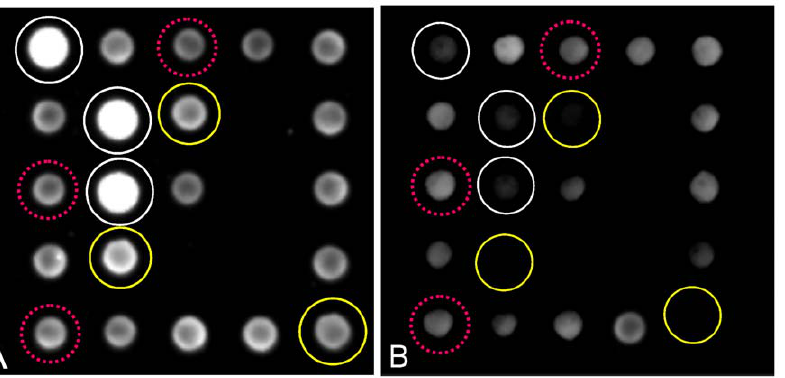
Figure 2. Differences in fluorescence signal intensity on the capture probe array at the first and the last cycle of a monoplex amplification reaction. A. An image of a hybridization pattern at the first cycle of the amplification reaction is shown. No target amplicon is present in the solution. The capture probe for the HIV-1 target specific reporter probe hr_H1_683 (solid yellow circle) as well as the non-target specific reporter probes, for example hr_H1_IPC (dotted red circle) show maximal signal intensity under the given reaction conditions. Initially, all reporter probes are free to bind to their respective capture probes on the array and show maximal signal intensity. The capture probe for hr_NHC shows no hybridization signal due to absence of a corresponding reporter probe. B. After 45 cycles of amplification, the target specific reporter probes hr_H1_683 are absorbed by the target amplicons and accumulate in the solution phase. The signal is ‘‘dragged’’ from the array into the solution, resulting in decreased fluorescence signal intensity on the complementary capture probe. In contrast, fluorescence signals for non-target specific reporter probes remain almost at their initial levels, for example hr_H1_IPC. In contrast to the hybridization probes, the covalently bound index spots (solid white circle) show significant bleaching effects. Bleaching is not observed on capture probes. This difference is due to the replenishing effect of the cyclic hybridization of reporter probes to the capture probes.